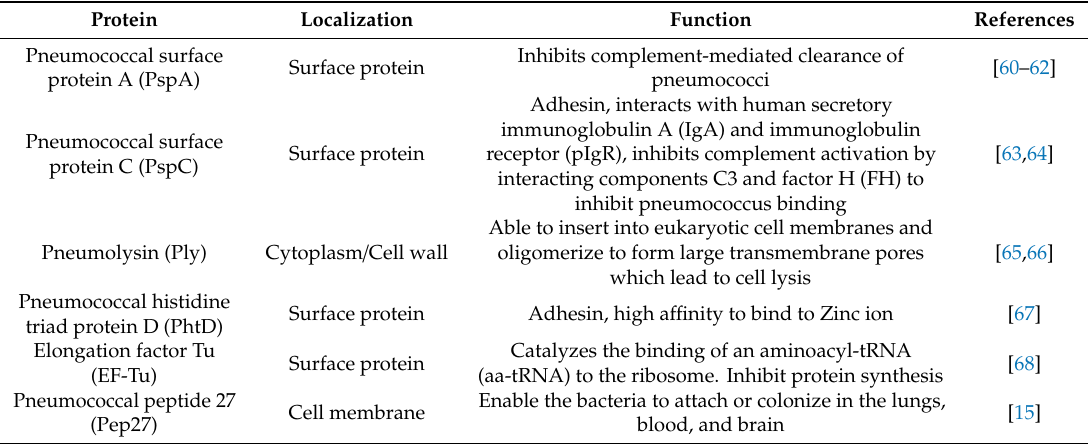
Table 1. Localization and function of Streptococcus pneumoniae virulence proteins that are well conserved among di ff erent